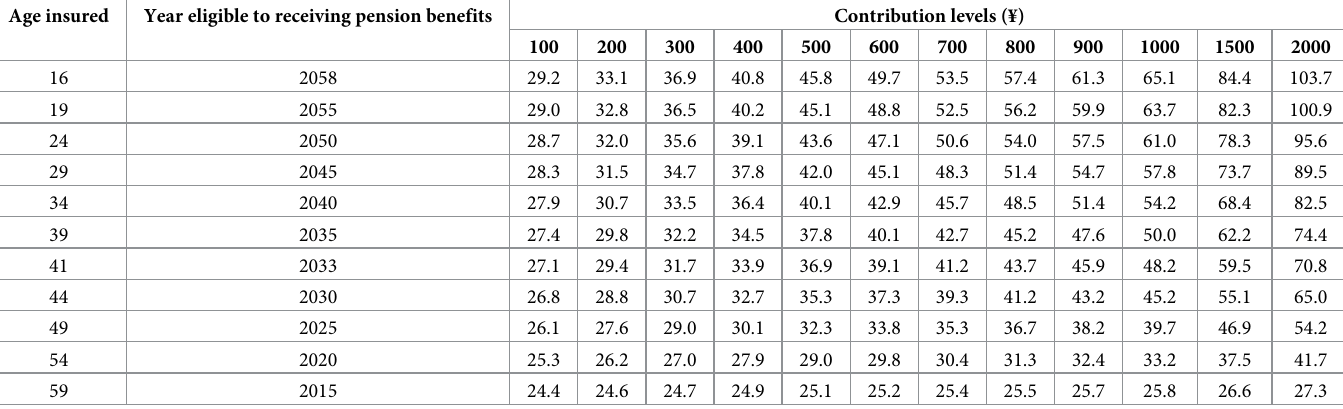
Table 4. The predicted actual replacement rate (ARR, %) of the insured residents aged below 60 (i.e., the middle aged and young people). Age insured Year eligible to receiving pension benefits